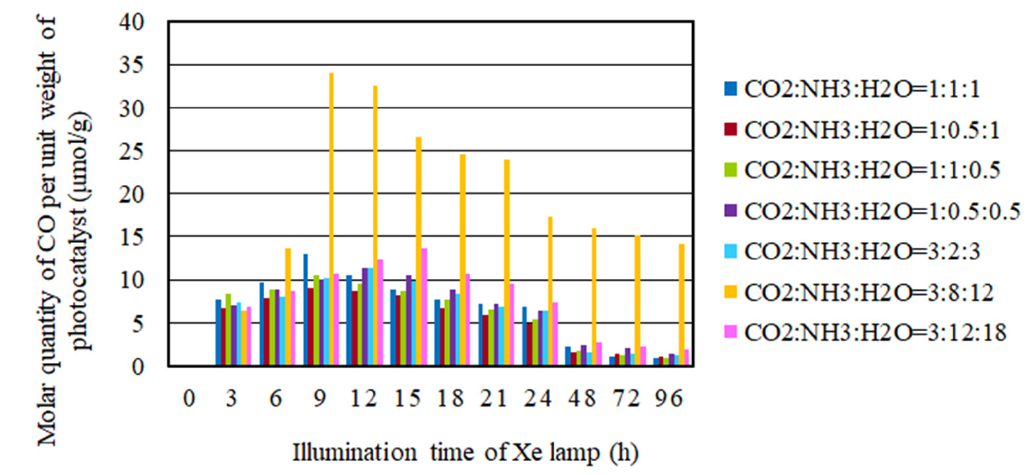
Figure 4. Comparison of molar quantity of CO per unit weight of photocatalyst under the illumination condition of Xe lamp with UV light. The pulse number is 200. The highest CO 2 reduction characteristic is obtained under the condition of the molar ratio of CO 2 /NH 3 /H 2 O = 3:8:12 where the molar quantity of CO per unit weight of photocatalyst is 34.1 mol/g.